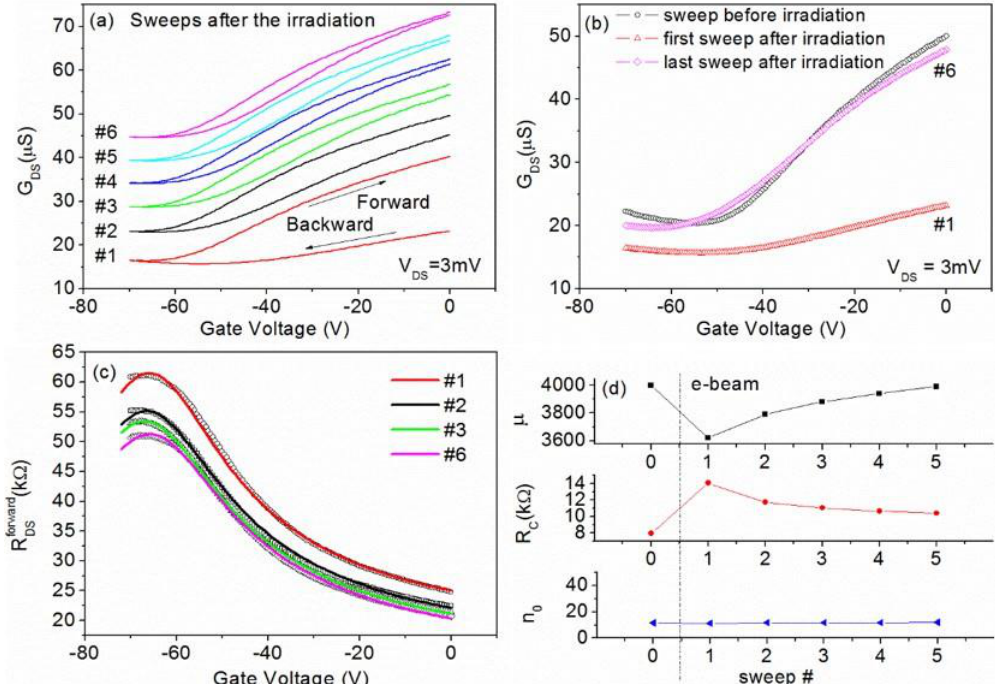
Figure 5. Effect of electron irradiation on R DS vs. V Gate of graphene field effect transistors (GFETs) characterized in Figure 3c. ( a ) Six successive sweeps recorded soon after the electron irradiation. Curves have been shifted for clarity. ( b ) Comparison of the first and sixth sweep after the 10 s e-beam exposure with that measured on unexposed device. ( c ) Forward sweep of selected measurements and relative fitting curves according to the model [32]. ( d ) Summary of parameters extracted by fitting of the curves corresponding to forward sweeps.